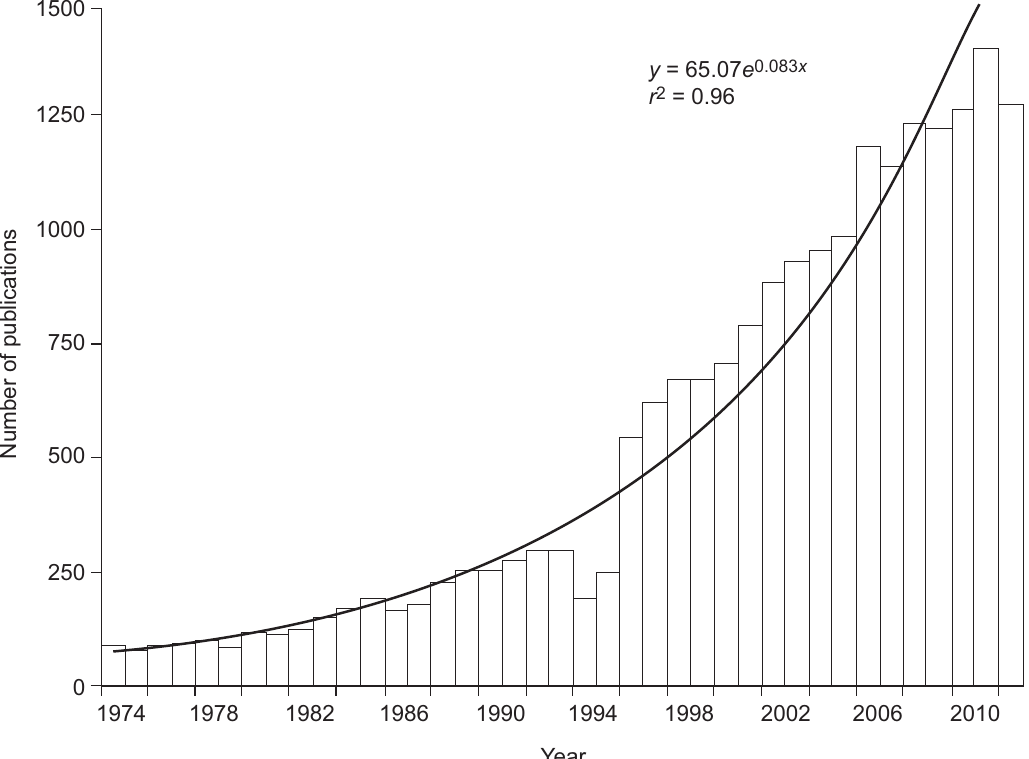
Fig. 1. The number of scientific articles on fish reproductive biology published during 1974–2012, based on data from Scopus (Anonymous 2012); The columns represent articles that included the words “spawning” or “maturity” or “fecundity” or “reproduction” or “reproductive biology” and “fish” in the field “Article Title, Abstract and Keywords” ( n = 20 300 for 1974–2012); The majority of the relevant articles were published in: Journal of Fish Biology , Aquaculture , Environmental Biology of Fishes , General and Comparative Endocrinology ,